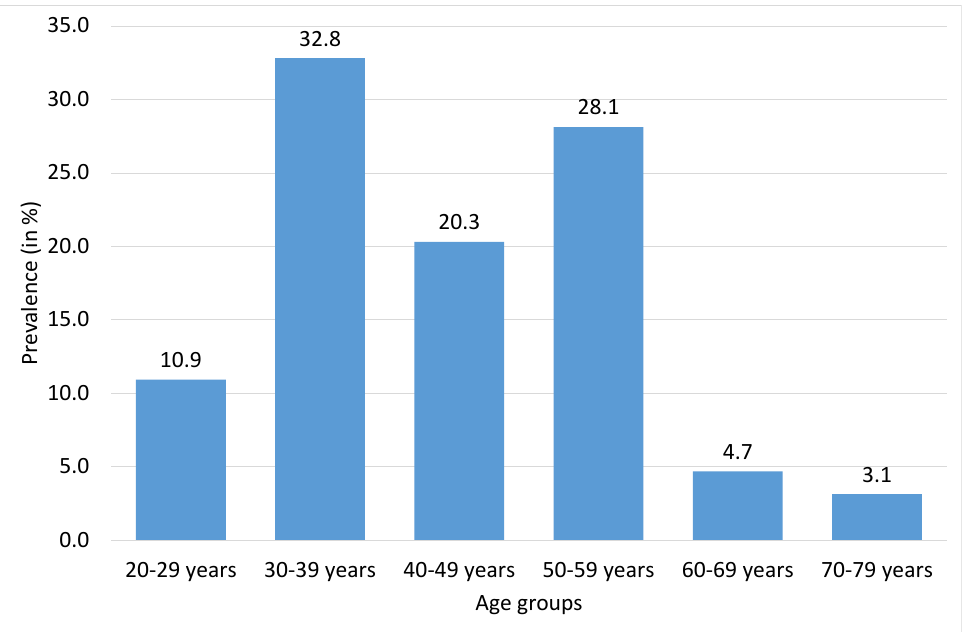
Figure 1. Prevalence of women diagnosed with systemic lupus erythematosus (SLE) by age groups (in %, N = 67). missing cases: age groups = 3.